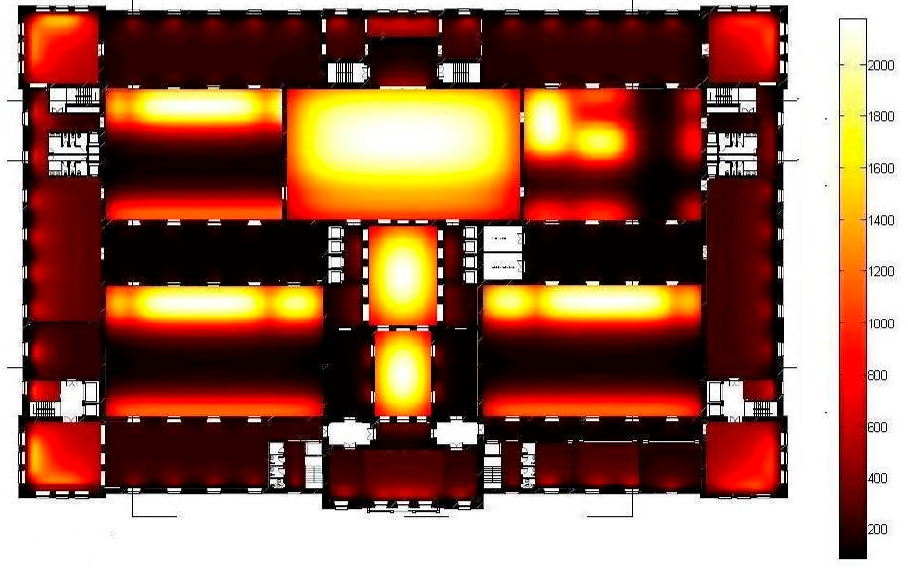
Figure 21. Radiation distribution in winter on the second